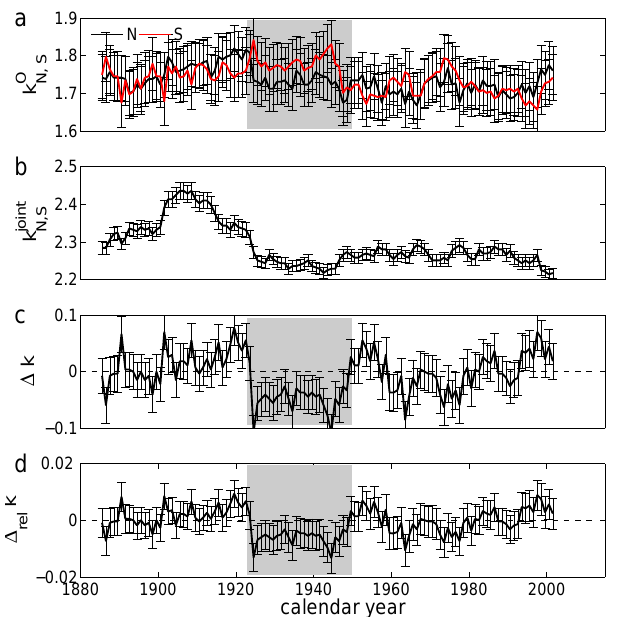
Figure 7. As in Fig. 6 for the corresponding HVG properties. The gray area indicates the only considerably long time interval with statistically significant hemispheric asymmetry of the mean condi- tional degree.